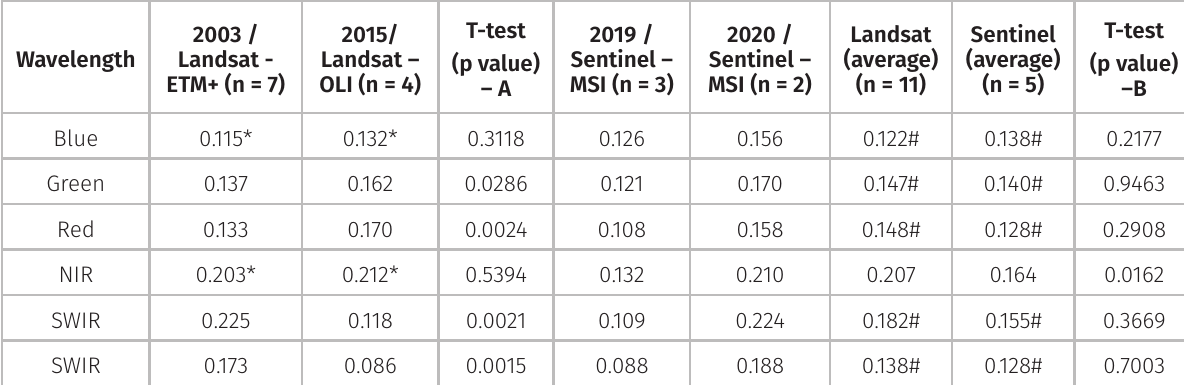
Table II. Algaes mean surface reflectance values for Landsat and Sentinel-2, number of samples and result of the t -test between Landsat sensors (A) and between the averages of both satellites